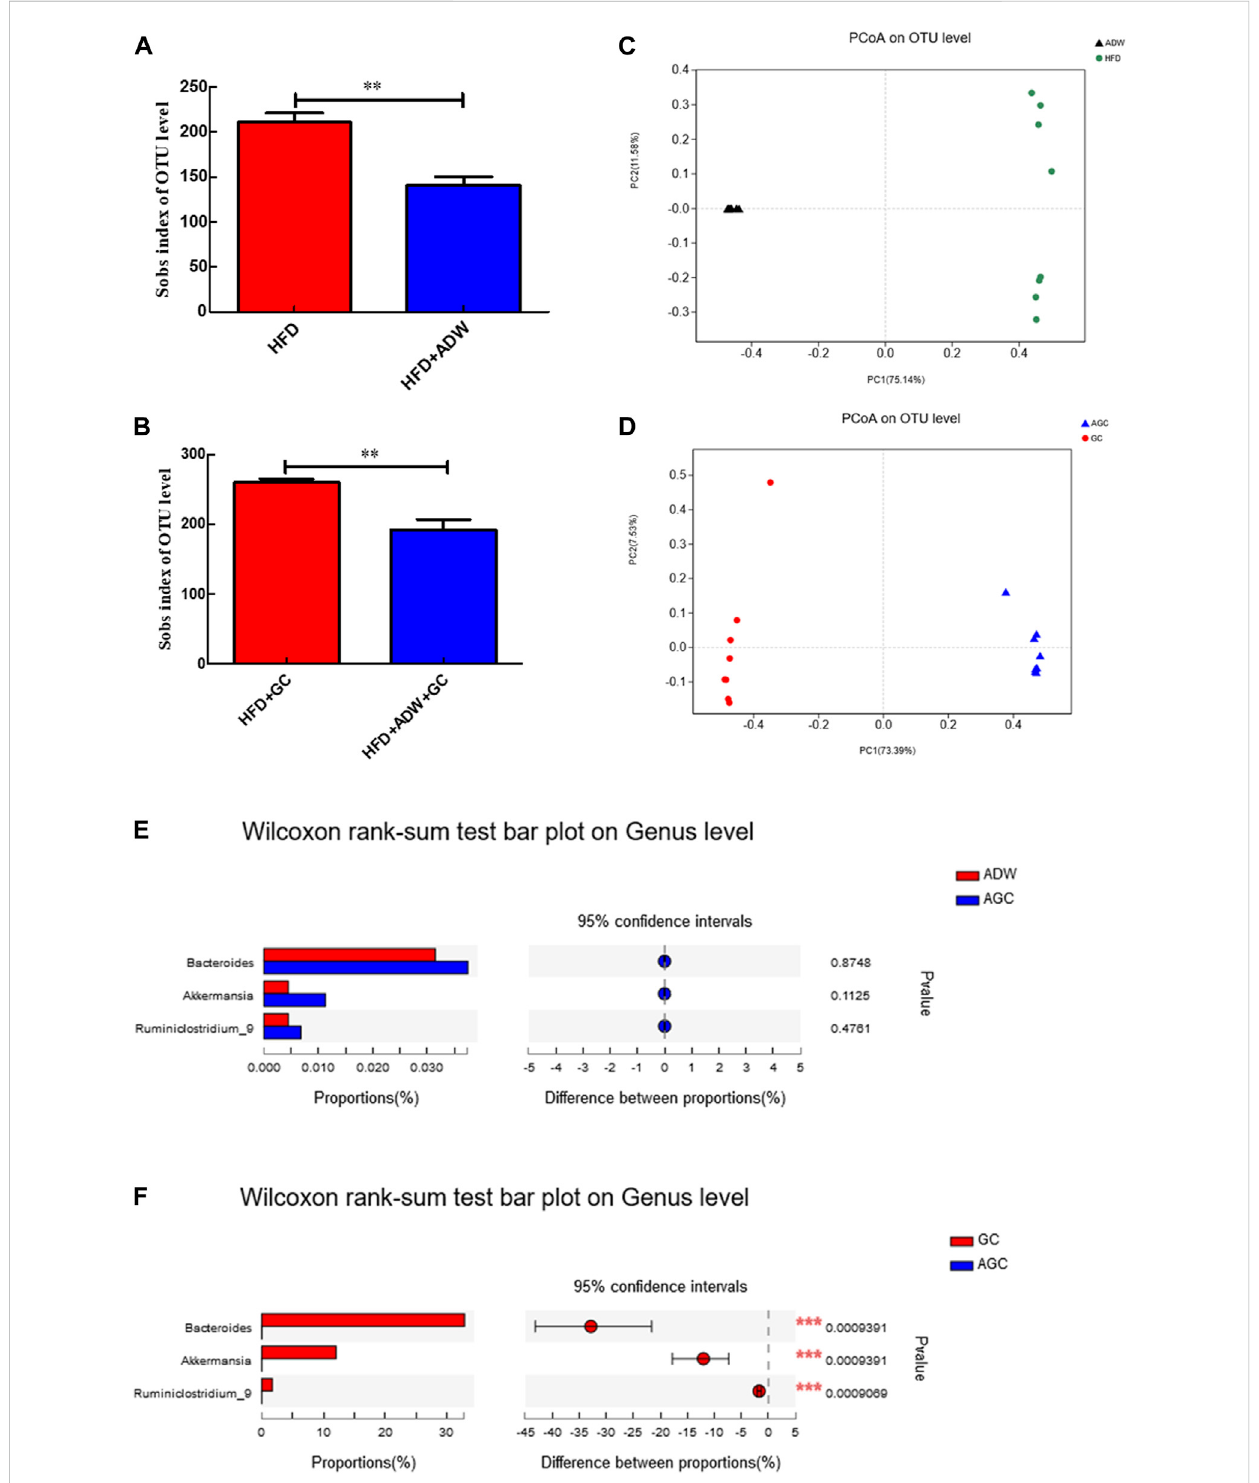
FIGURE 3 Changes in the gut microbiota and intervention with GC with or without ADW in a mouse NAFLD model. (A, B) Alpha diversit of the gut microbiota. (C, D) Beta diversity analyzed using PCoA of the gut microbiota in each labeled group. (E) Wilcoxon rank-sum test results of changes at the genus level between the ADW and AGC groups. (F) Wilcoxon rank-sum test results of changes at the genus level between the GC and AGC groups. Abbreviations: NAFLD, non-alcoholic fatty liver disease; ADW, antibiotic drinking water (containing ampicillin, neomycin, vancomycin, and tinidazole); GC, geniposide and chlorogenic acid combination treatment; ND, normal diet; HFD, high-fat diet; PCoA, principal coordinate analysis; OTU, operational taxonomic unit. ** p < 0.01 ( n = 8 per